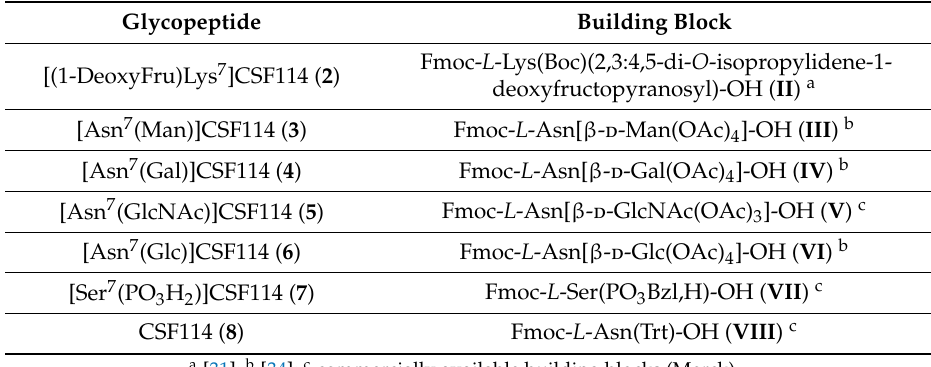
Table 3. Model peptides 2 – 7 based on the β -turn structure CSF114 ( 8 ) bearing, at position 7, di ff erent post-translational